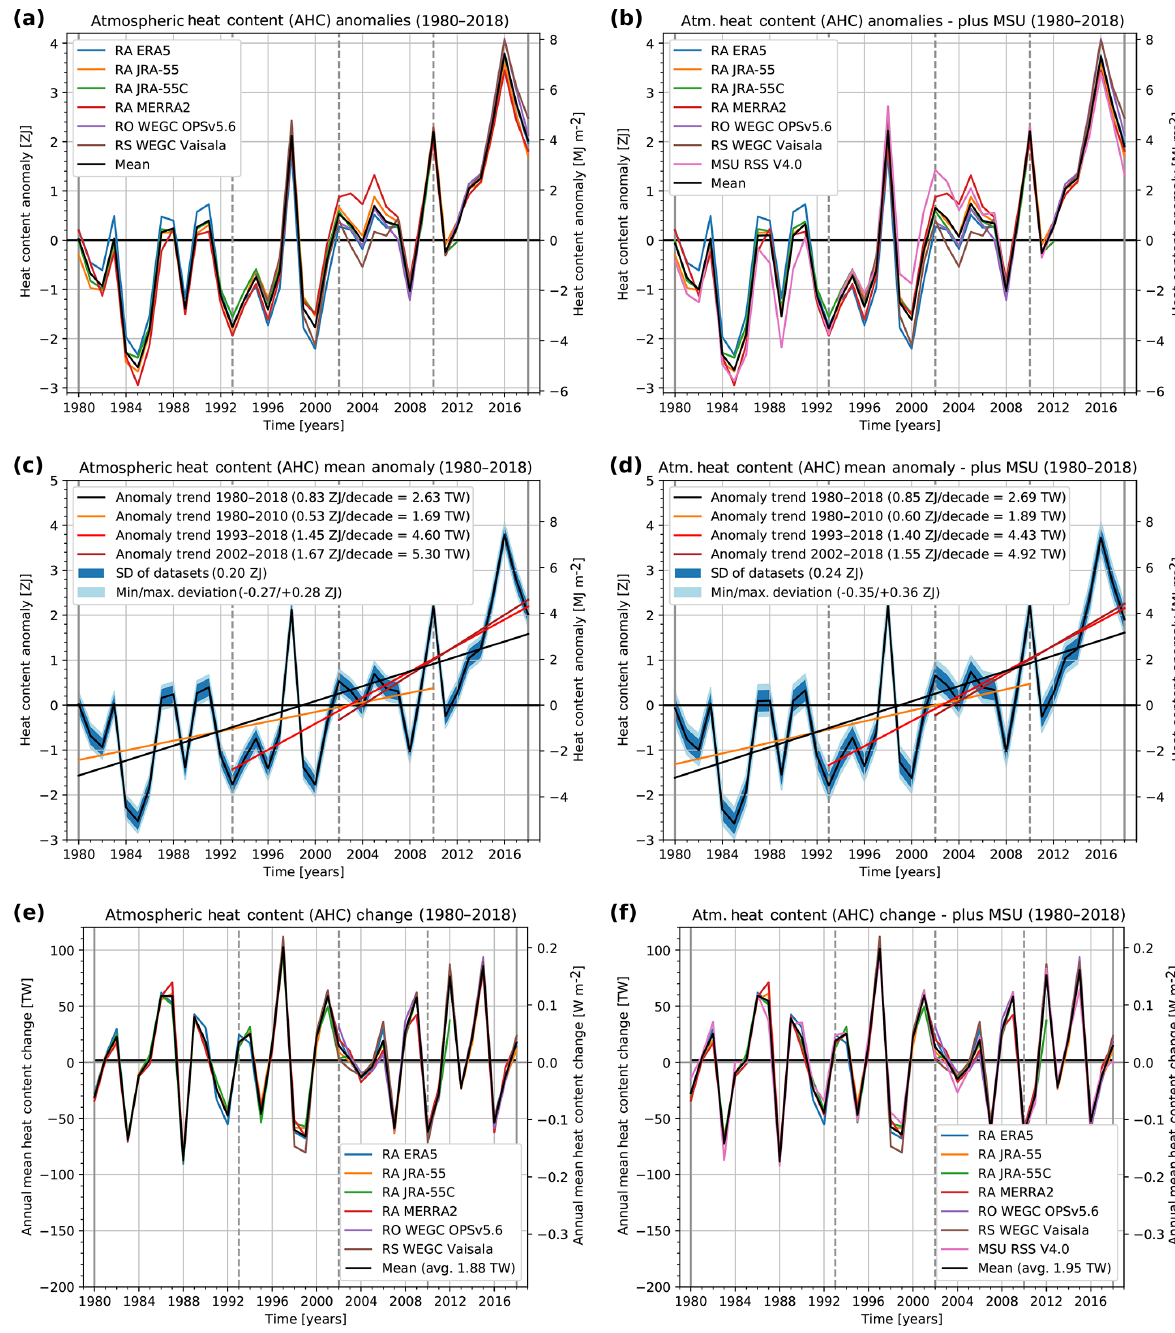
Figure 3. Annual-mean global AHC anomalies over 1980 to 2018 of four different reanalyses and two (a, c, e) or three ( b, d, f , plus MSU) different observational datasets shown together with their mean (a, b) , the mean AHC anomaly shown together with four representative AHC trends and ensemble spread measures of its underlying datasets (c, d) , and the annual-mean AHC change (annual tendency) shown for each year over 1980 to 2018 for all datasets and their mean (e, f) . The in-panel legends identify the individual datasets shown ( a, b and e, f ) and the chosen trend periods together with the associated trend values and spread measures (c, d) , with the latter including the time-average standard deviation and minimum/maximum deviations of the individual datasets from the